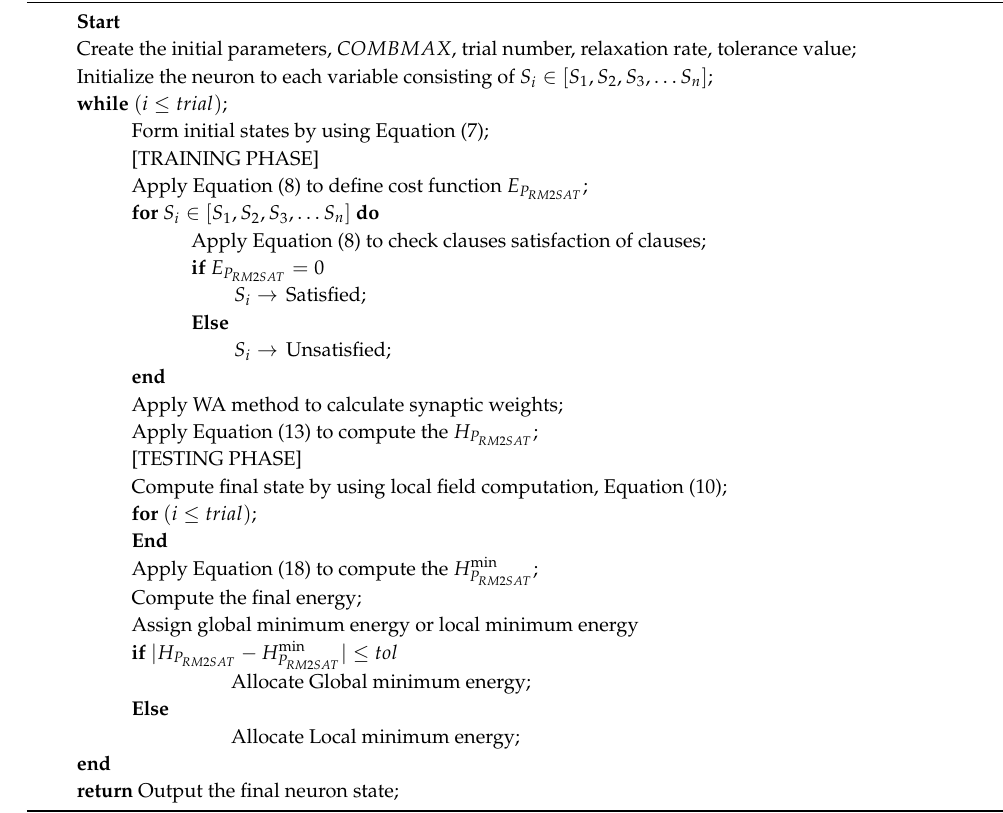
Algorithm 1: The pseudocode of